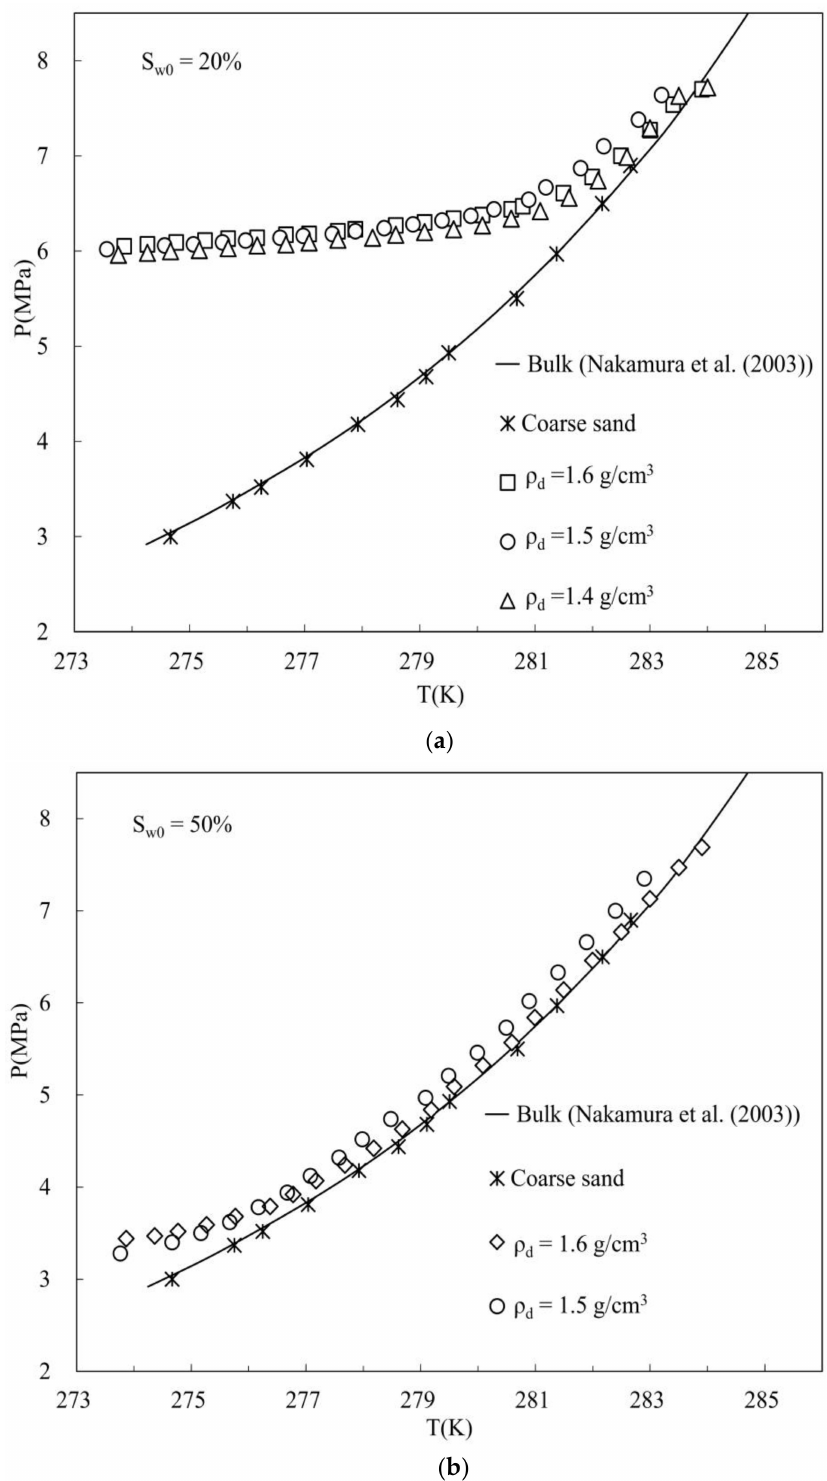
Figure 6. The stability conditions of methane hydrate in fine-grained sediment under different dry densities. ( a ) Low initial water saturation and bulk data [35]; ( b ) high initial water saturation and bulk data